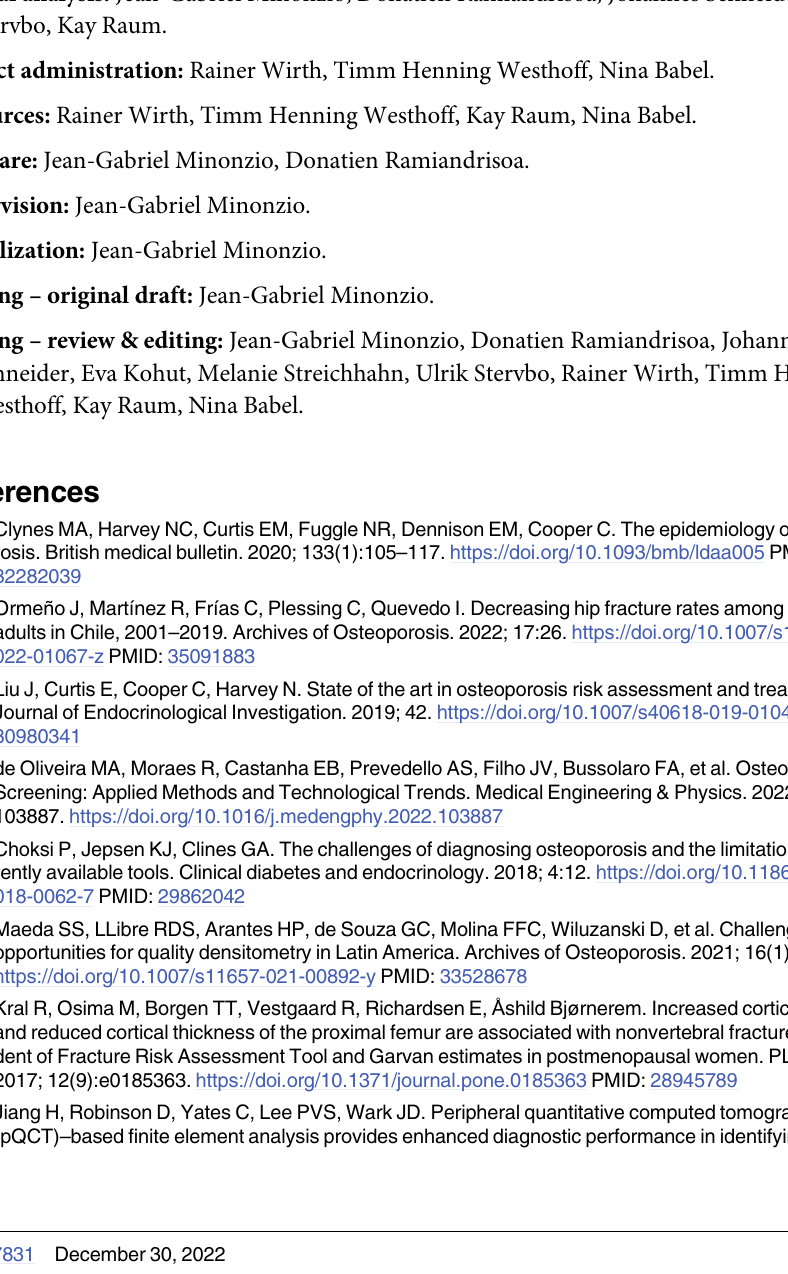
S2 Table. Discrimination obtained with logistic regression: Odds ratios (OR) and areas under the ROC curve (AUC) for both techniques BDAT and DXA and the second popula- tion (87